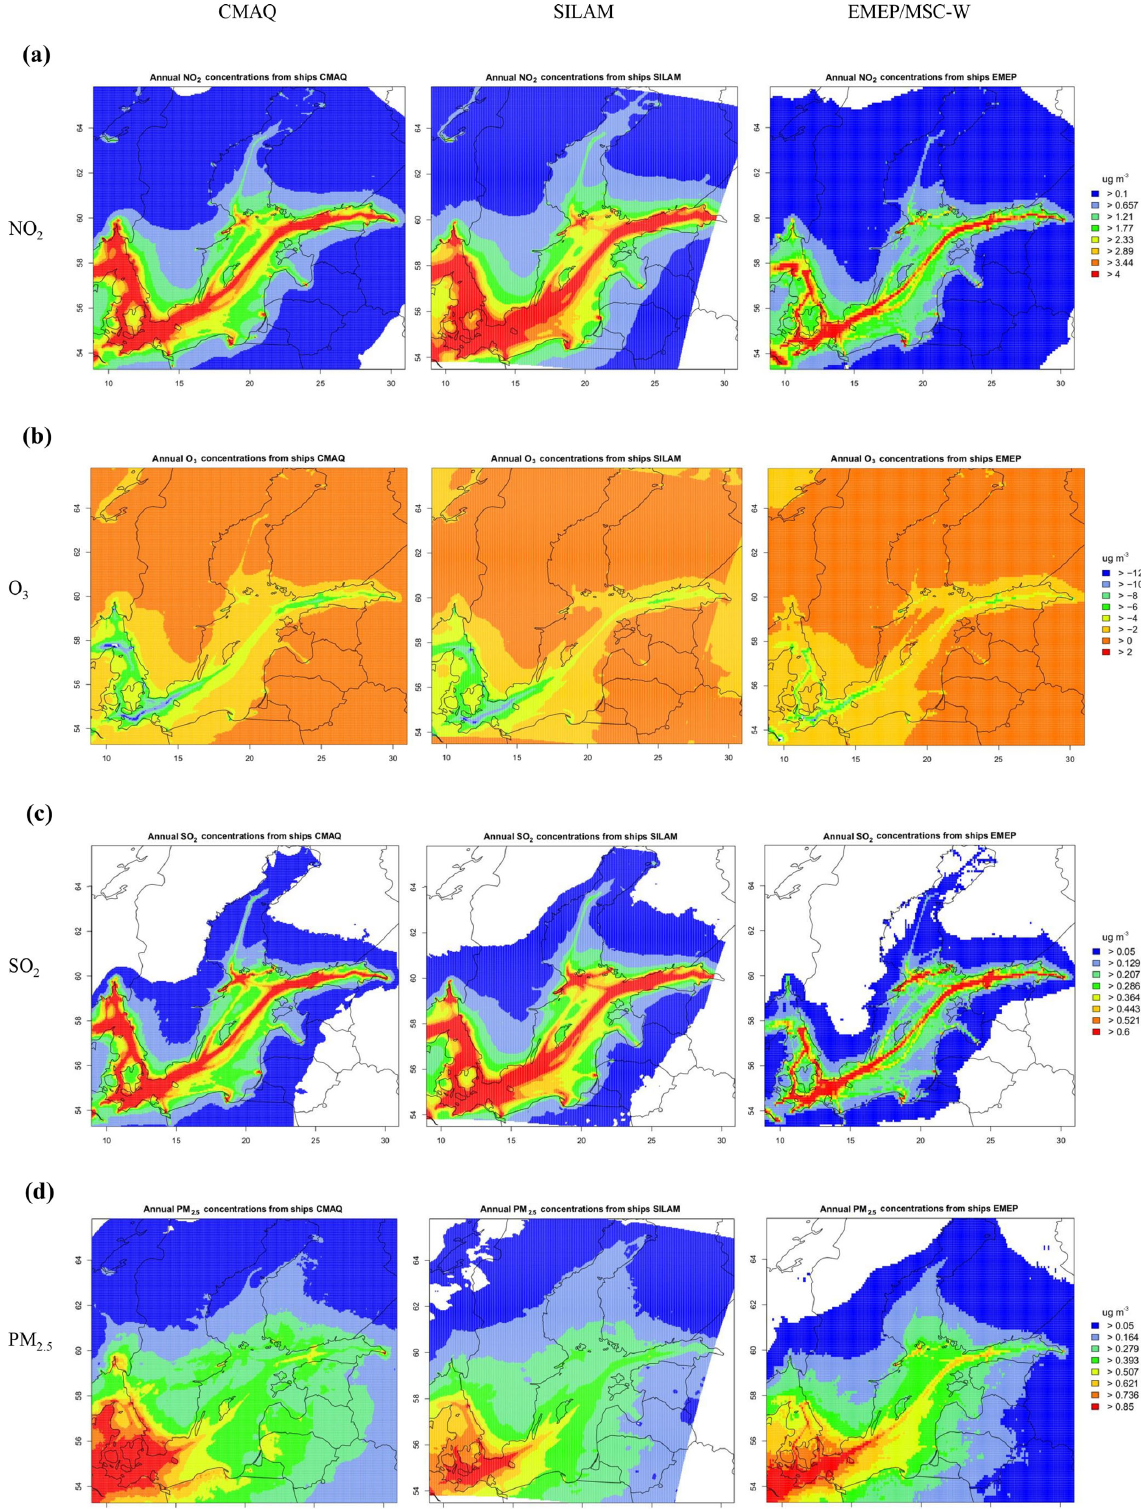
Figure 9. Comparison of the spatial distribution of annual mean ship-related concentrations (absolute ship contributions in µgm − 3 ) of the CMAQ (left column), SILAM (middle column) and EMEP (right column) models in the Baltic Sea region for (a) O 3 , (b) NO 2 , (c) SO 2 and (d) PM 2 . 5